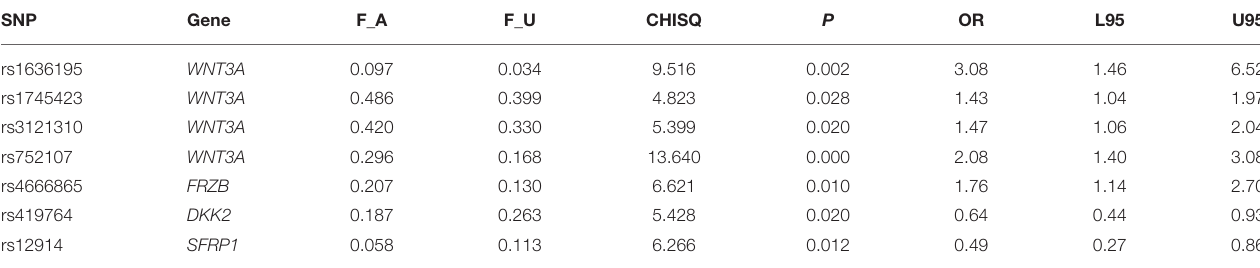
TABLE 1 | SNPs associated with EH in the exploration cohort.